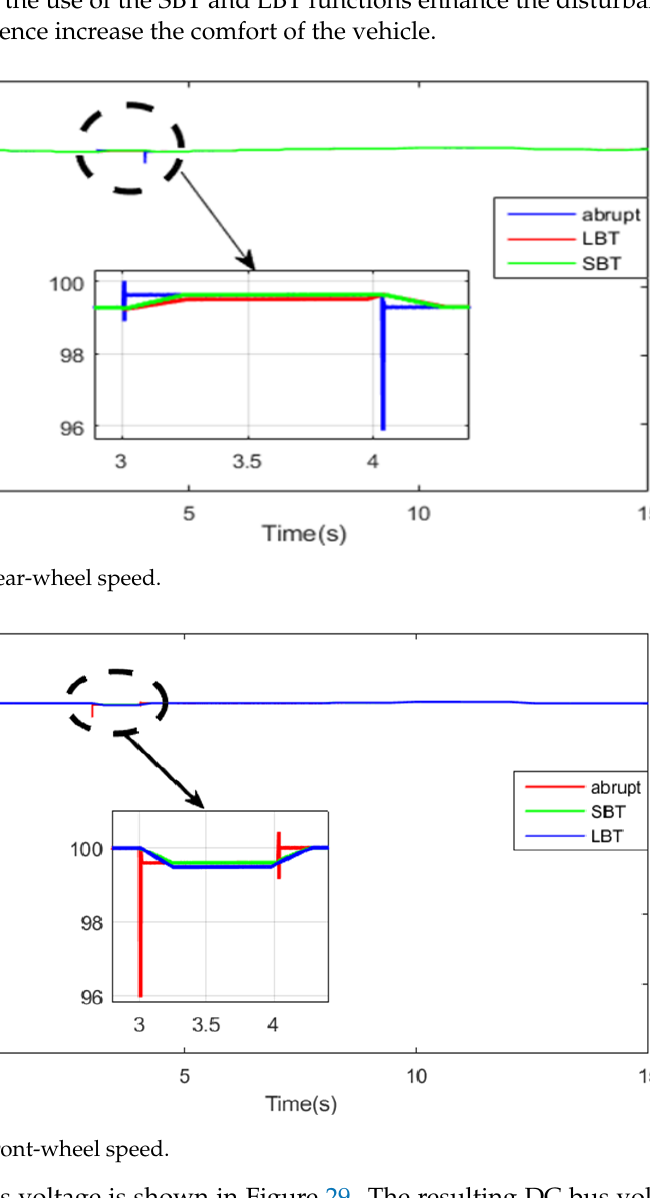
Figure 29. DC bus voltage.